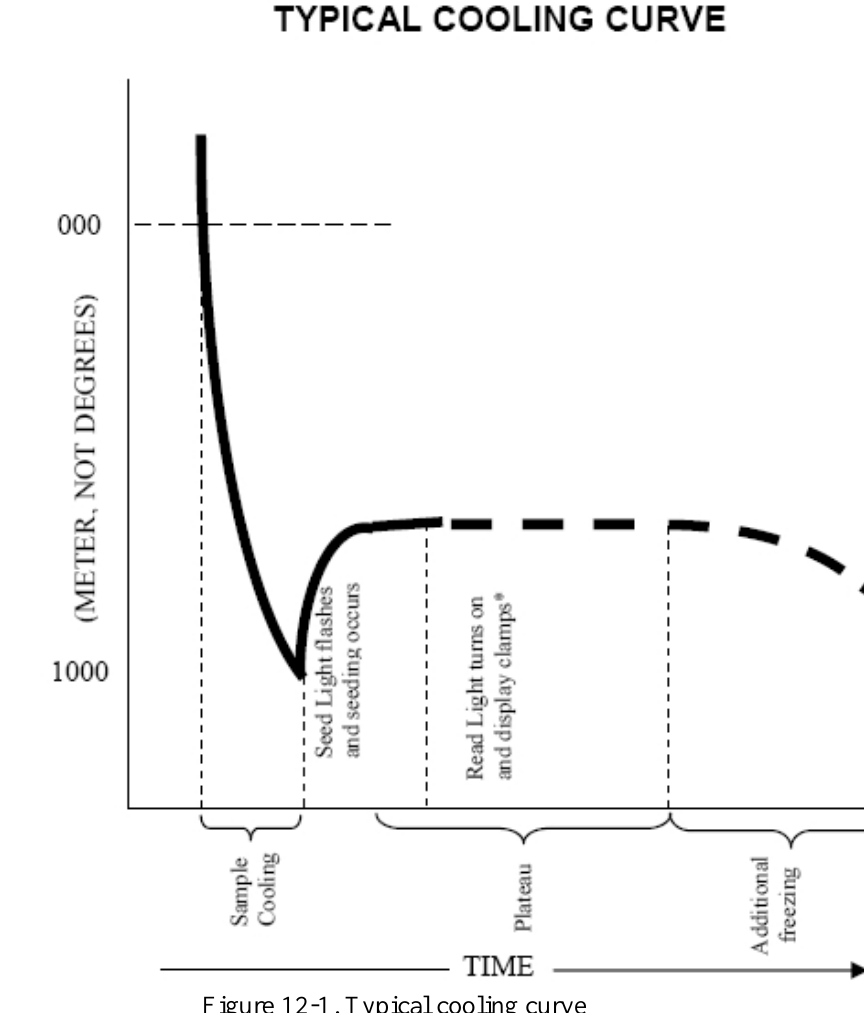
Figure 12-1. Typical cooling